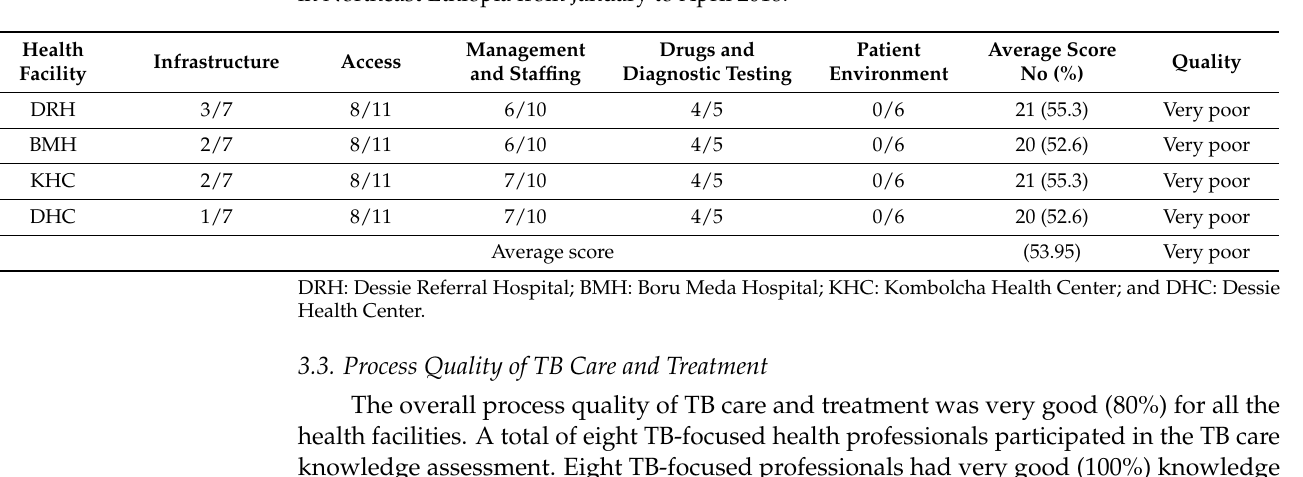
Table 2. Structural quality score of public-health facilities providing TB care at public-health facilities in Northeast Ethiopia from January to April